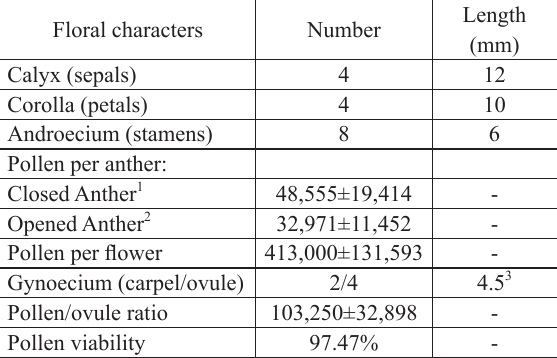
Fig. 1 - Rhizophora mangle L. (Rhizophoraceae) in goiana, northern coast of Pernambuco, Brazil. A . Cymose inflorescence of the type dichasium; B . Flower at male phase on the first day of anthesis; C . Flower at the male phase on the second day of anthesis; D . Flower at female phase on the third day of anthesis. Bar = 10 mm.